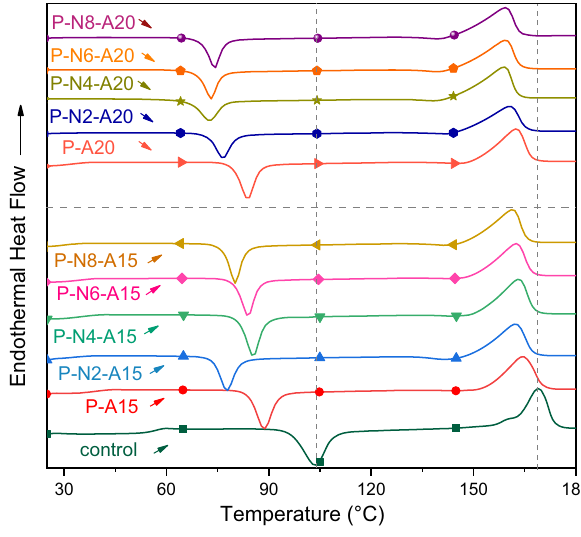
Figure 4: DSC thermograms of pure PLA and PLA/NFC composites.